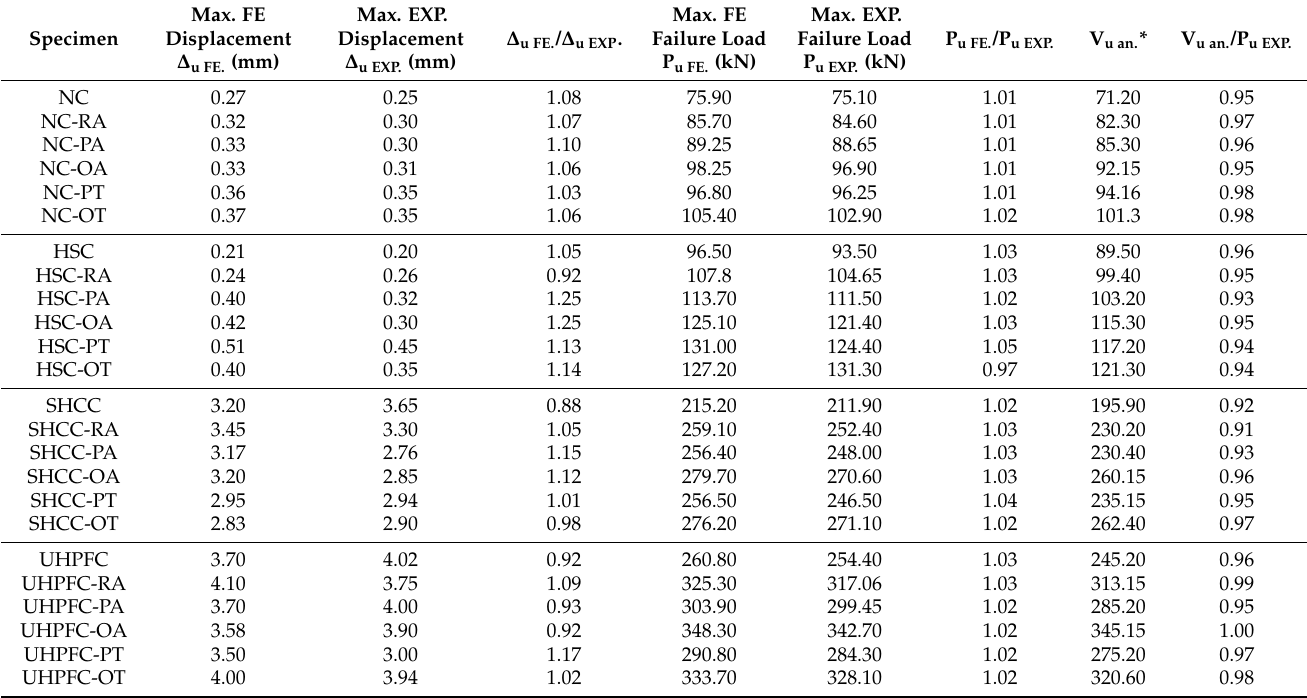
Table 5. Difference between numerical model and experimental